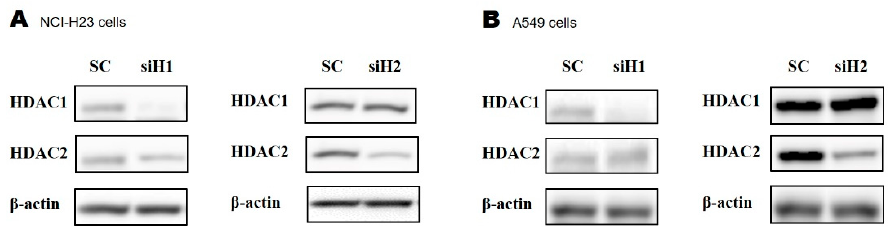
Figure 3. Silencing HDAC1 or HDAC2 using specific siRNA. The ( A ) NCI-H23 and ( B ) A549 cells were incubated for 48 h after transfection with 150 nM siH1 (siRNA targeting HDAC1), siH2 (siRNA targeting HDAC2), and scrambled RNA (scRNA). The levels of HDAC1 and HDAC2 expression were analyzed by Western blotting using anti-HDAC1 and anti-HDAC2 monoclonal antibodies. β -actin was used as the loading control.